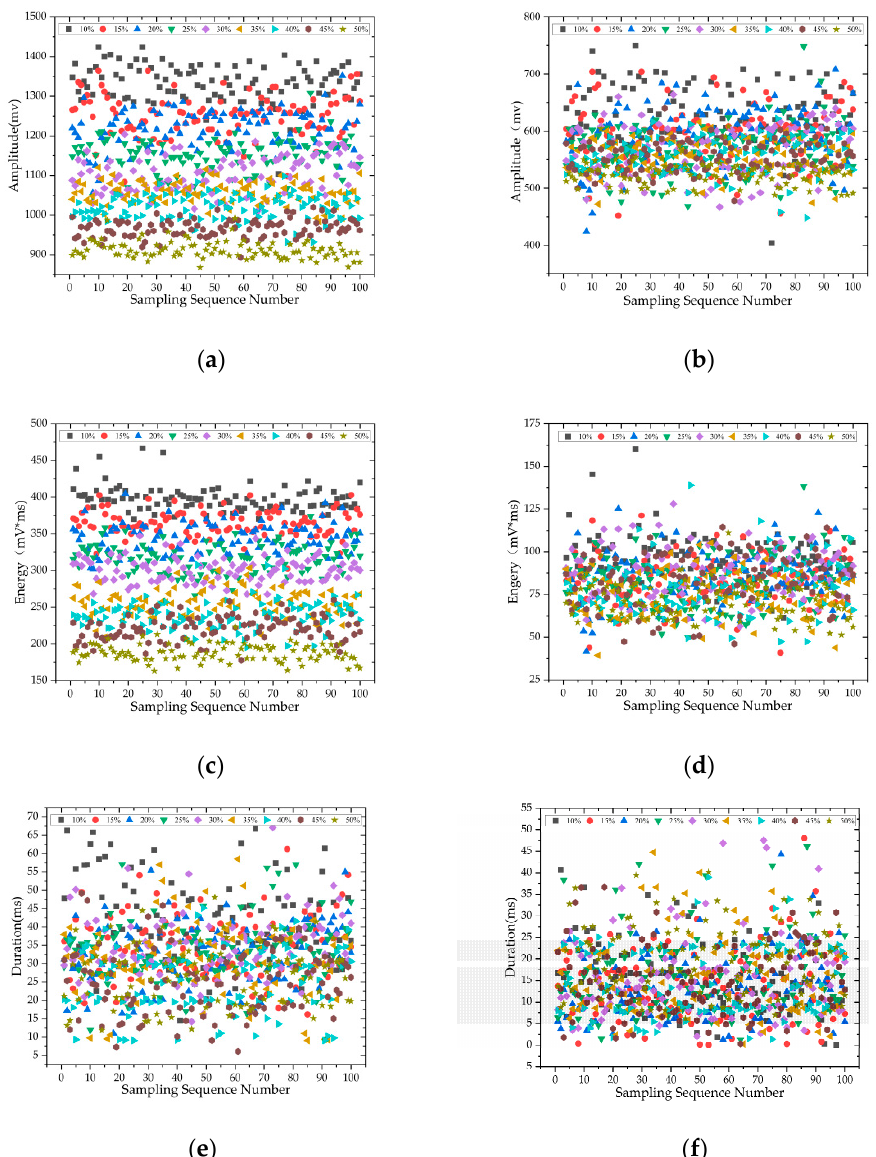
Figure 16. Proximal/distal AE signal acquisition data for each wood sample. ( a ) Proximal AE amplitude; ( b ) distal AE amplitude; ( c ) proximal AE energy; ( d ) distal AE energy; ( e ) proximal AE duration; ( f ) distal AE duration.